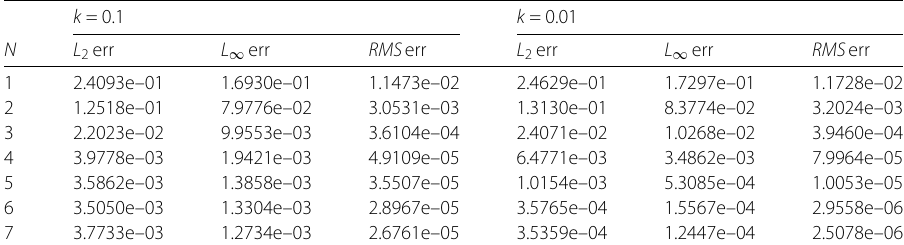
Table 1 Numerical results for sine-Gordon equation Example 5.1 with N e = 20 and T = 1 k = 0.1 k =